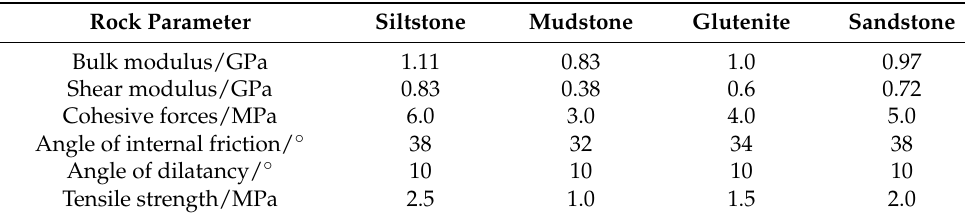
Figure 2. Three-dimensional space numerical model of a bottom pumping roadway [39]. ( a ) Force analysis diagram; ( b ) numerical model diagram. Table 1. Physical and mechanical parameters of rock